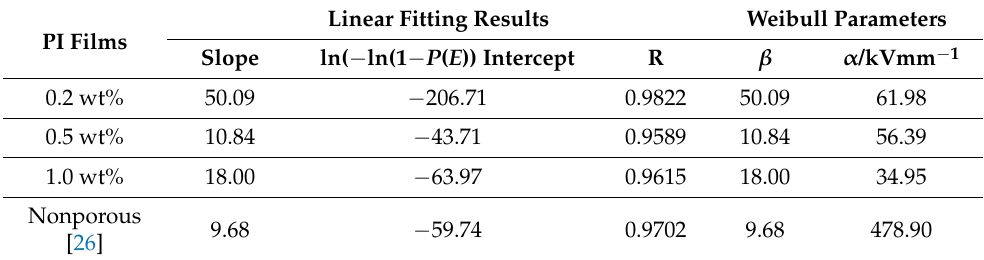
Figure 6. Weibull distribution of the different porous PI films. Table 1. Fitting data and Weibull distribution parameters of porous PI